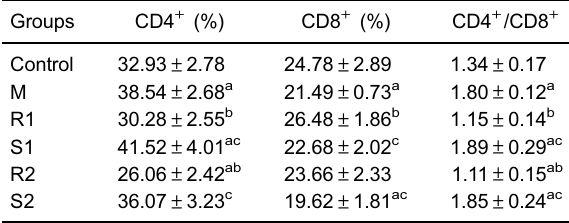
Table 1. Flow cytometry results of CD4 + , CD8 + and CD4 + /CD8 + .